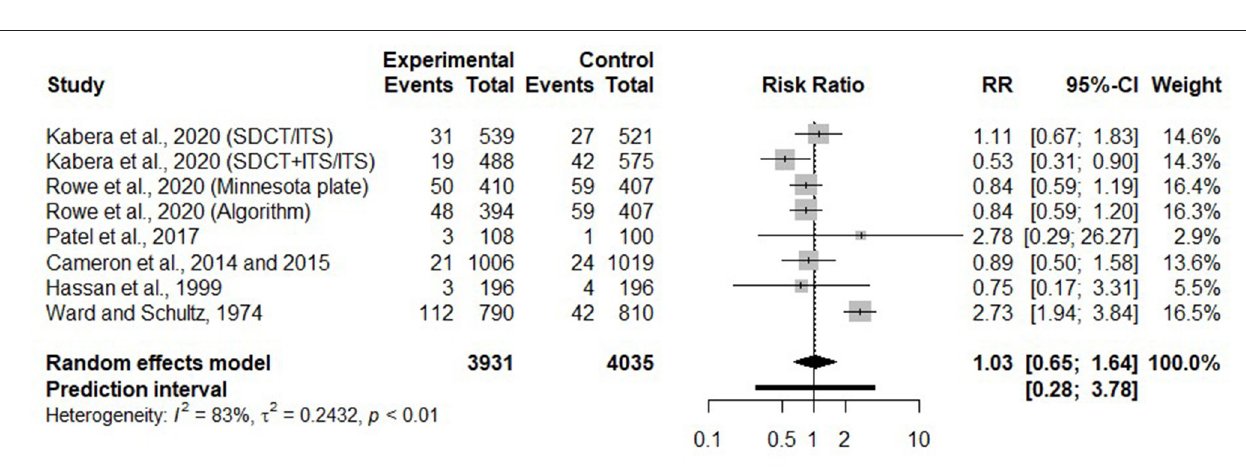
FIGURE 7 | Forest plots showing the effect of selective dry cow treatment compared with blanket dry cow therapy on risk of acquiring CM during the first 4 months of lactation.